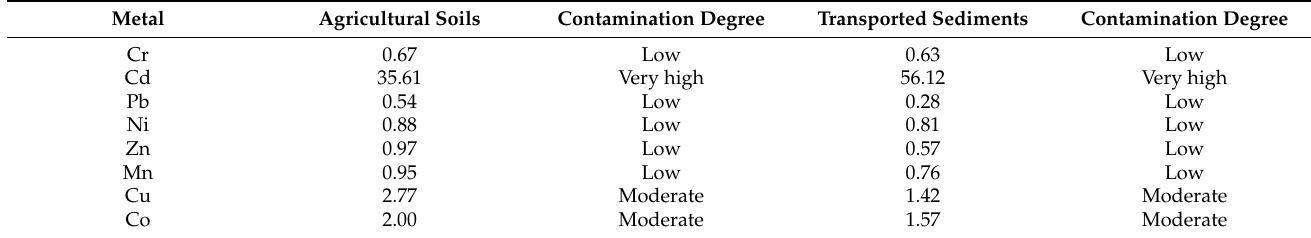
Table 4. Contamination factors for agricultural soils and transported sediments.